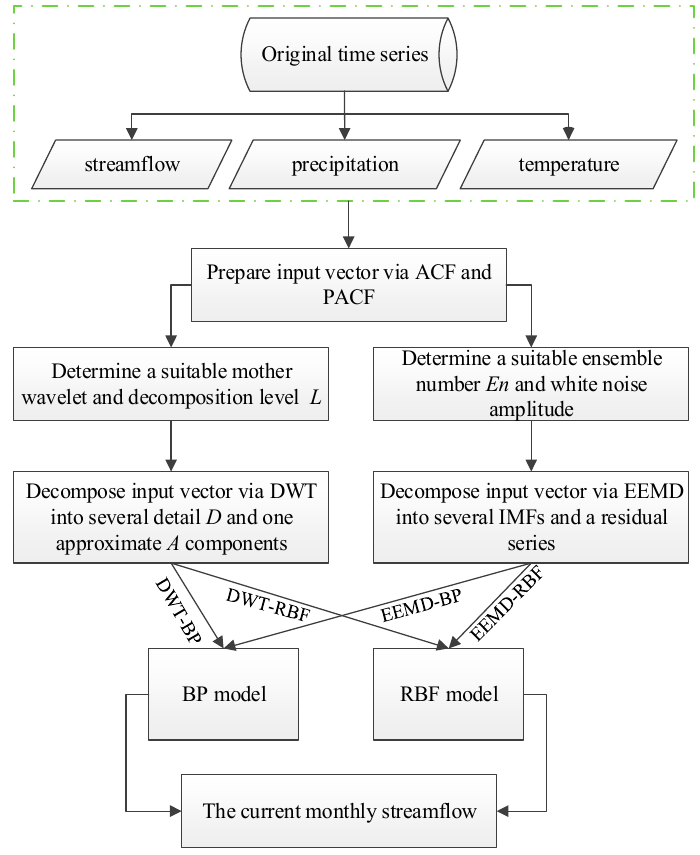
Figure 13. The flowchart of the hybrid models.